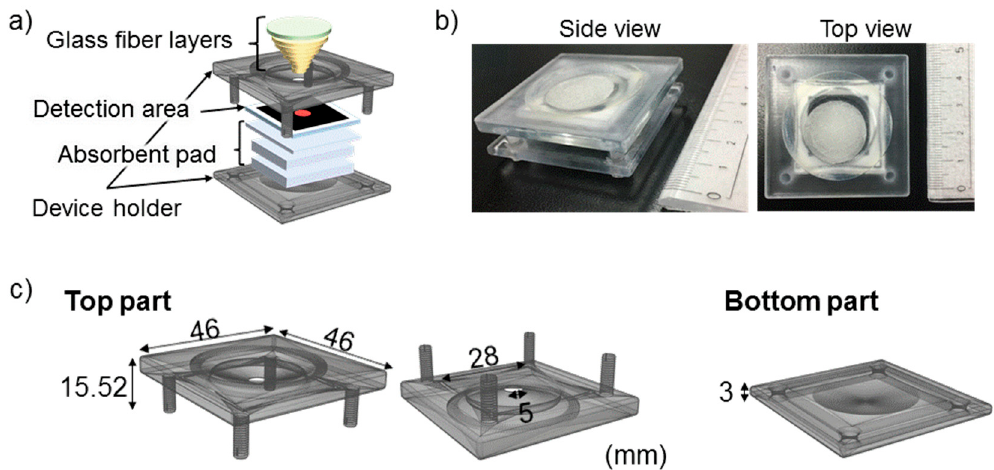
Figure 1. Design of the 3D-PAD for the detection of Zn 2+ with integrated pretreatment and concentration systems: ( a ) schematic illustration; ( b ) actual photograph; ( c ) schematic illustration of disassembled device holder fabricated by 3D-printing.